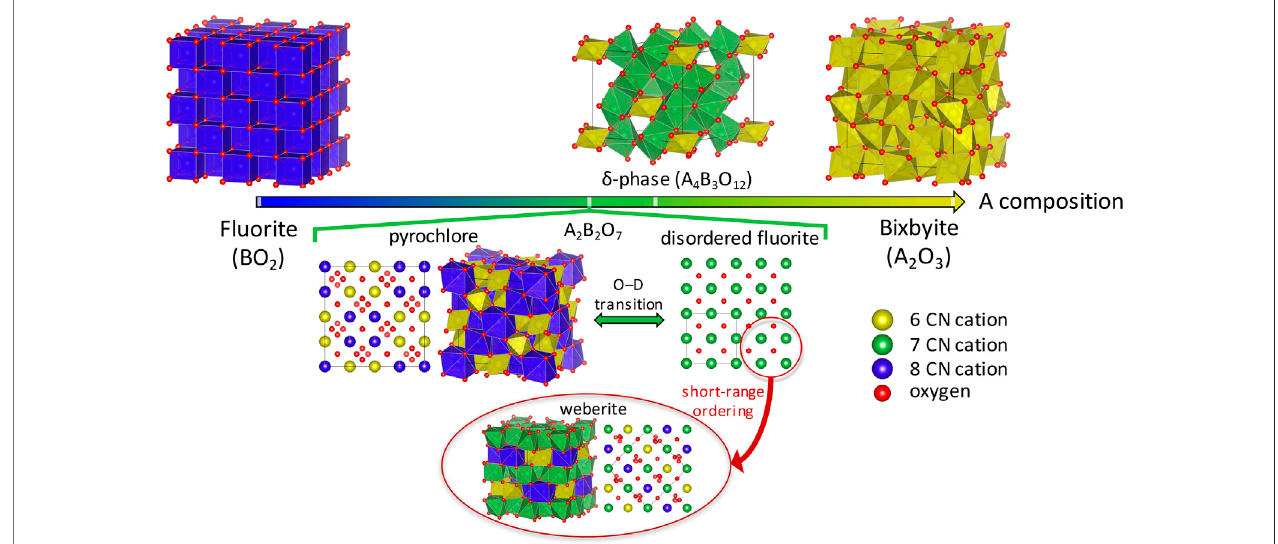
FIGURE1| Schematicrepresentationoftheanion-de fi cient fl uoritestructuralderivativeoxides,goingfroma fl uorite(BO 2 )toabixbyite(A 2 O 3 )crystalstructure.The cationic sites with coordination number (CN) of6,7 and 8areshown as yellow,green, and bluespheresand polyhedra, respectively,while theoxygenatoms areshown asredspheres.Thelowerhalfhighlightshow, upondisordering, a fl uorite-derivativestructure suchaspyrochlorecanundergoanorder-disordertransitiontoastructure resembling disordered fl uorite on the long-range, but has short-range order more accurately described by a weberite-structure.